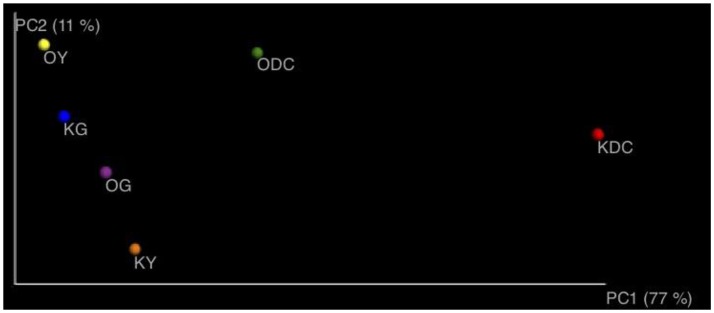
Principal coordinate analyses of axes 1 and 2 using weighted unifrac distances.